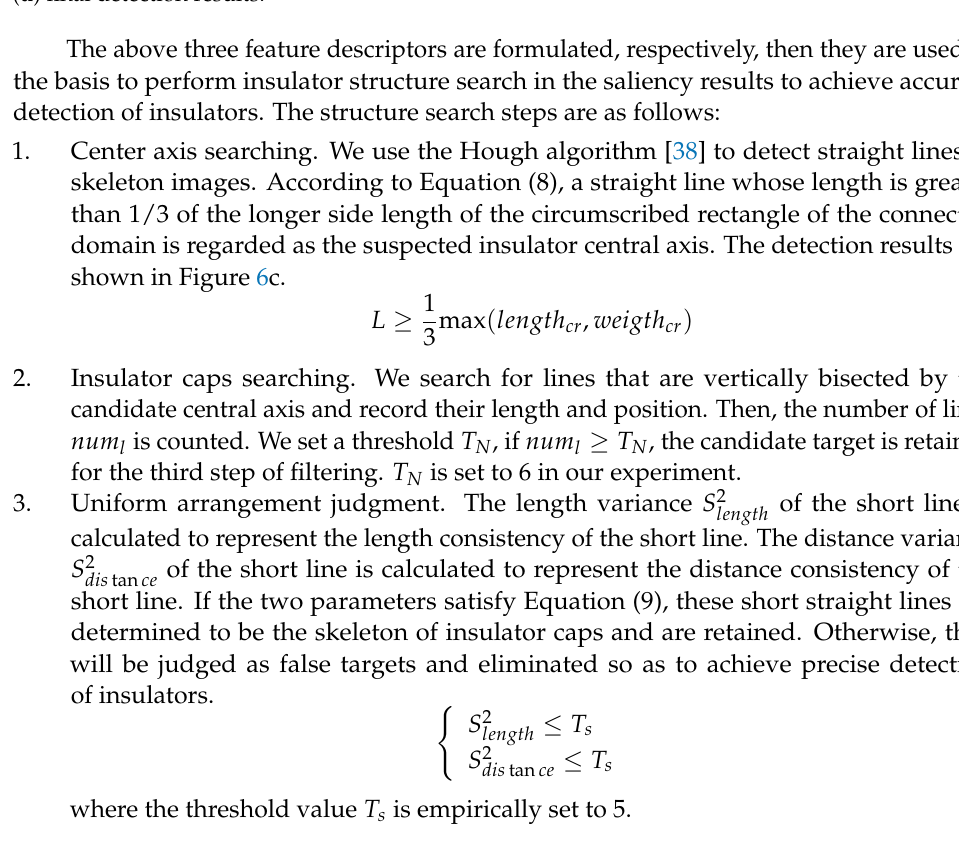
Figure 6. Structure searching: ( a ) binary saliency maps; ( b ) skeleton structure diagram; ( c ) center axis ( d ) final detection results.